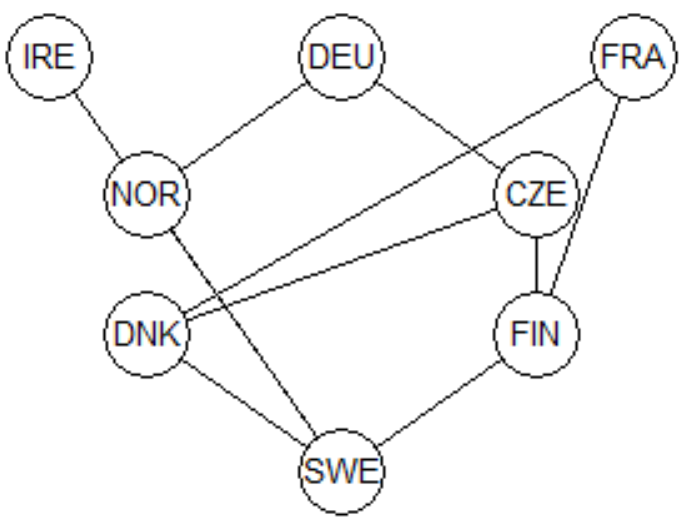
Figure 1. Graphical representation of the partial order of the above exemplary case.